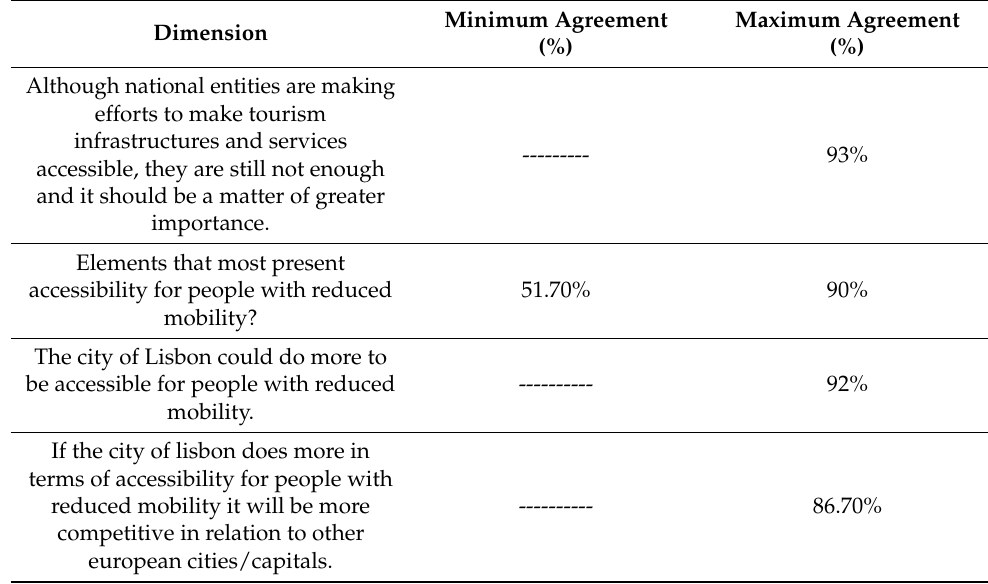
Table 17. Maximum and minimum agreement of the third domain of the interviews. Source: Elaborated by the